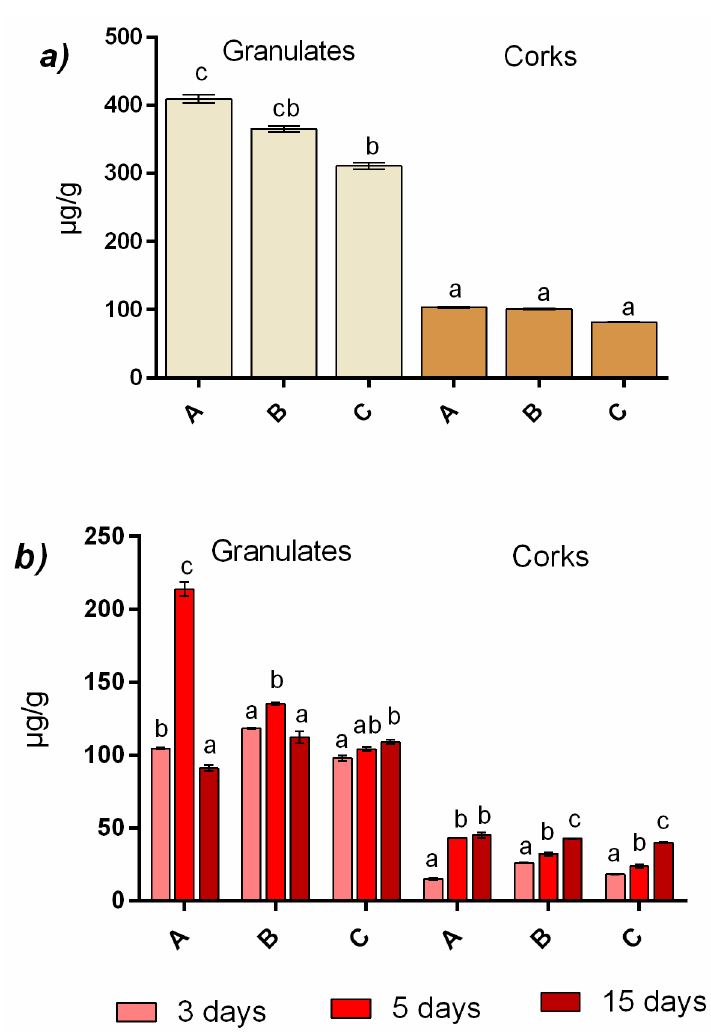
Figure 2. Total aromatic compounds (mean ± SD) of granulates and corks ( a ) and total aromatic compounds of granulates and corks at di ff erent time of extraction ( b ). Di ff erent particle size from cork stoppers and their respective granulates (A; high, B; medium, C; small). Di ff erent letters indicate significant di ff erences, p < 0.05.